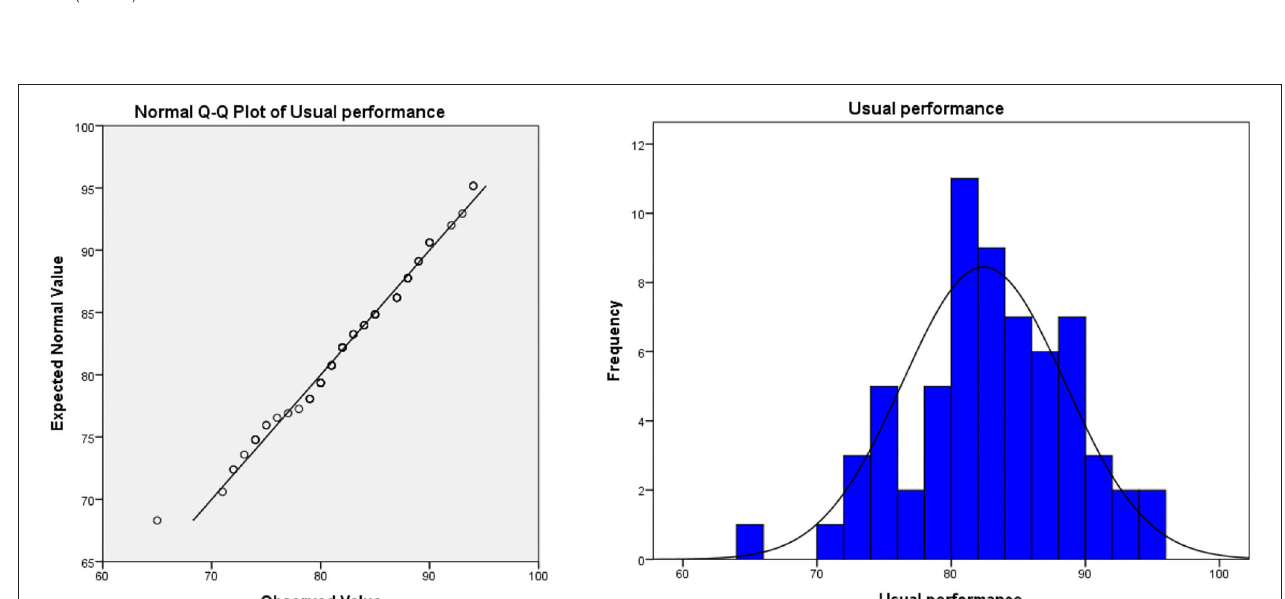
FIGURE 5 | Usual performance of an online-offline teaching model.